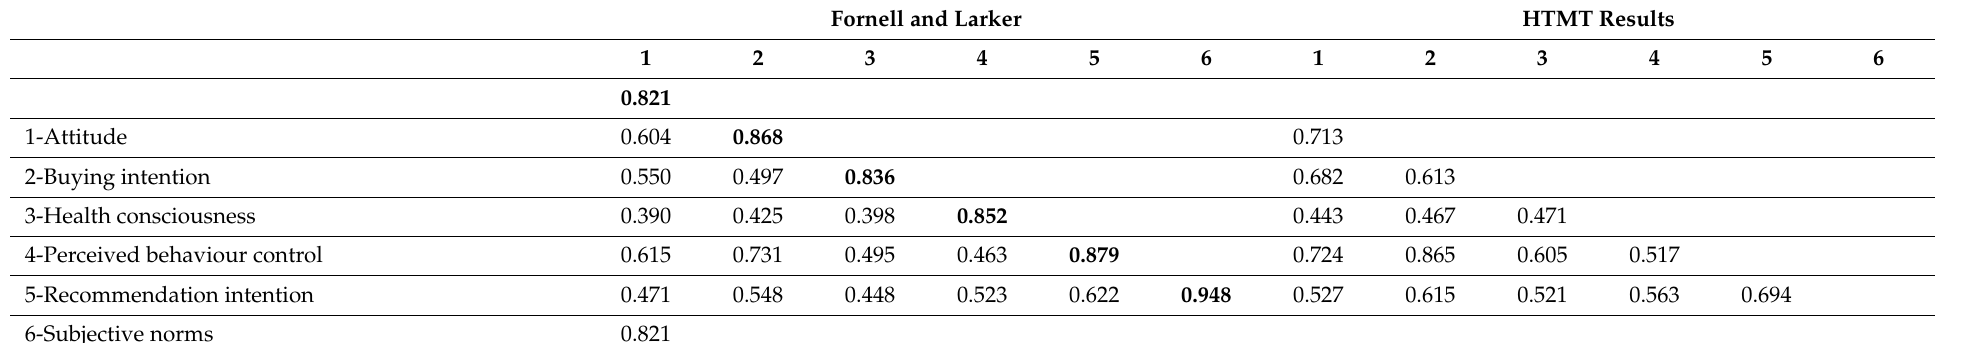
Table 4. Discriminant validity (KSA data